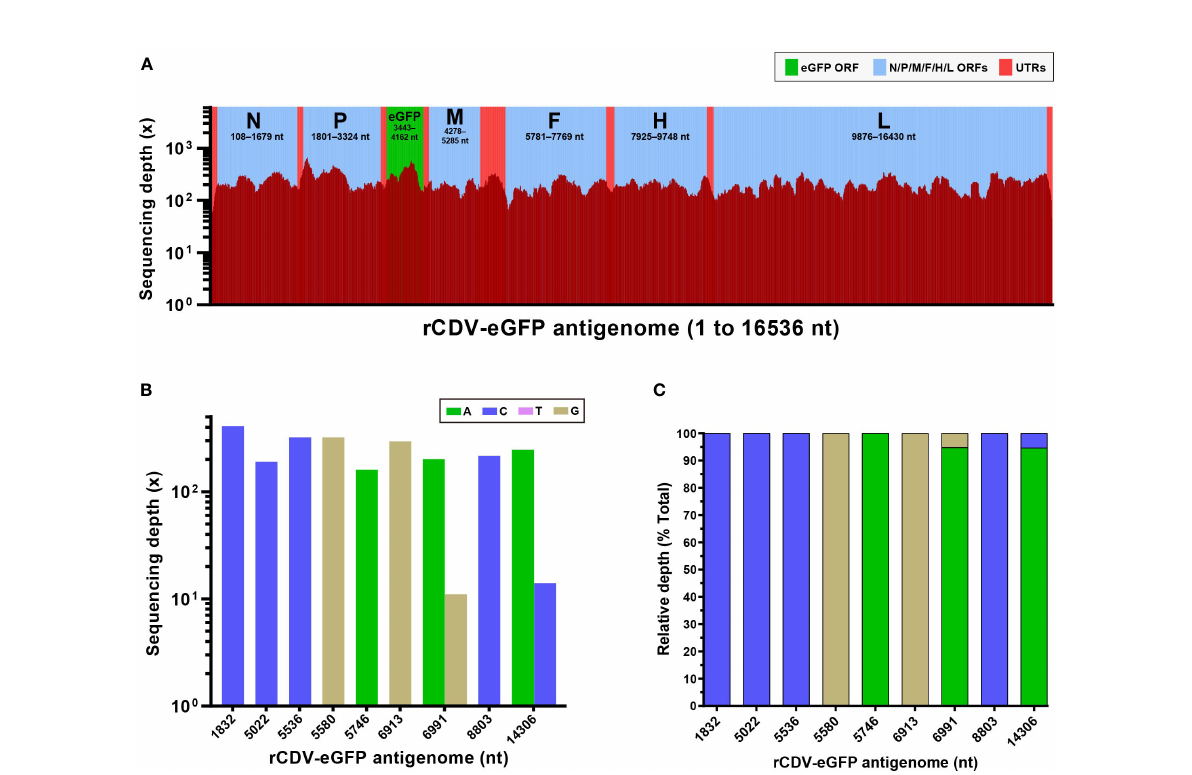
FIGURE 3 NGS analysis of rCDV-eGFP population at P47. Sequencing depth and coverage of NGS for the full-length rCDV-eGFP antigenome at P47 (A) . All elements proportionally match their actual lengths within the viral antigenome. ORF, open reading frame; UTR, untranslated region. Absolute (B) and relative (C) sequencing depths of SNMs in the rCDV-eGFP antigenome at P47. SNMs at nt 1832, 5022, 5536, 5580, 5746, 6913 and 8803 are recognized as total single-nucleotide substitution, but at nt 6991 and 14306, are characterized by single-nucleotide